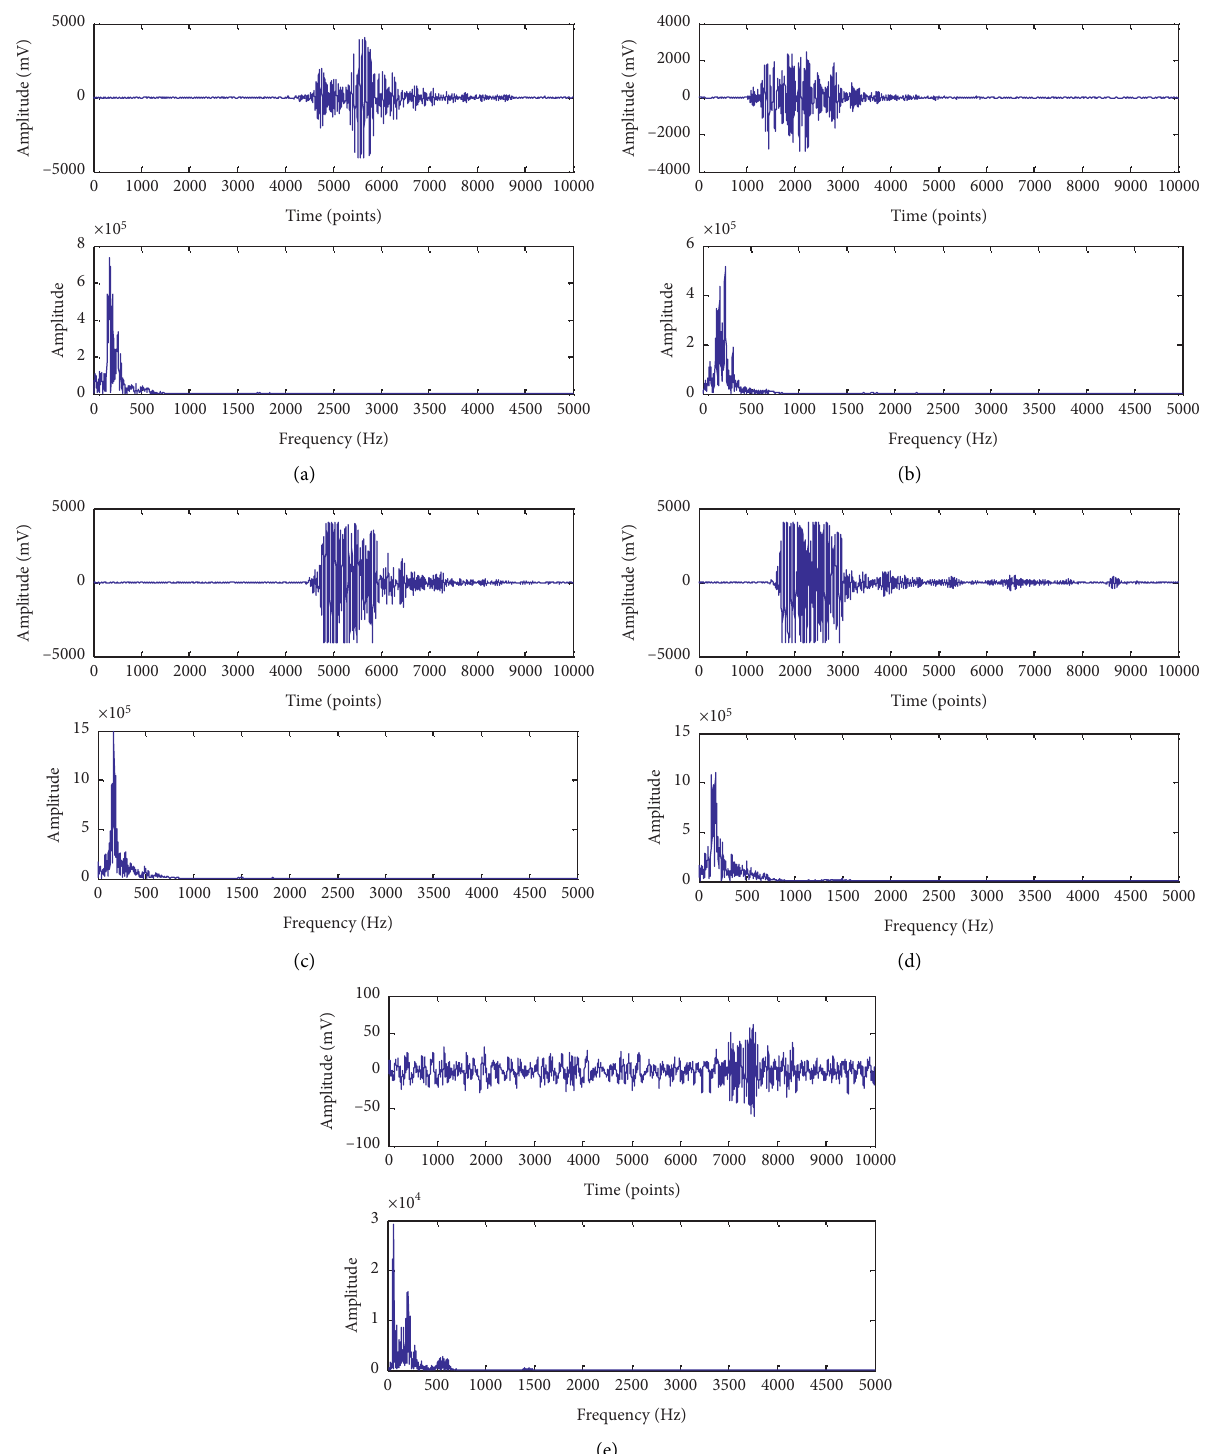
Figure 5: Signal waveform extraction of different microseismic events: (a) rock fracture signal, (b) rock fracture signal, (c) coal caving signal, (d) coal caving signal, and (e) noise